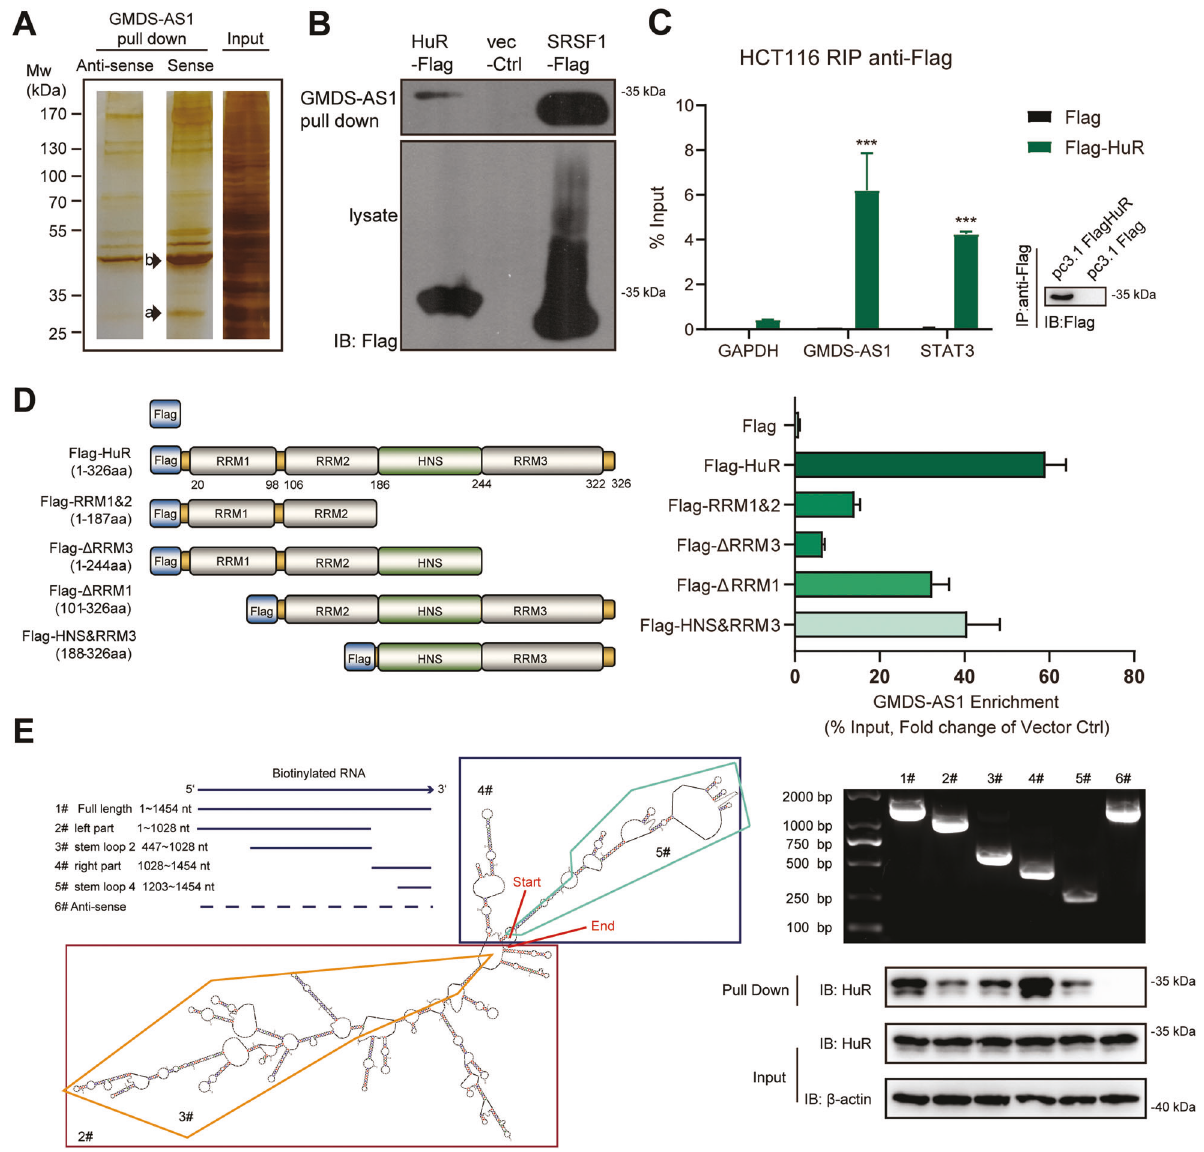
Fig. 5 GMDS-AS1 binds to the HuR protein in CRC cells. A Biotinylated GMDS-AS1-sense and antisense probes were transcribed in vitro and incubated with HCT116 whole-cell lysates for use in RNA pull-down assays. After SDS – PAGE and silver staining, 28 kDa (arrow a) and 37 kDa (arrow b) GMDS-AS1-sense-speci fi c bands, which repeatedly appeared in two independent assays, were excised and analyzed by mass spectrometry. B Streptavidin RNA pull-down assays and western blotting were performed, and the results validated the speci fi c interactions of HuR or SRSF1 protein with GMDS-AS1. Representative results based on three independent experiments. C Plasmids expressing Flag-tag alone and Flag-HuR were transfected into HCT116 cells, and RIP experiments were performed using antibodies against Flag; qPCR was used to detect GMDS-AS1 and STAT3 mRNA levels. GAPDH mRNA was used as the non-HuR target negative control. The values are expressed as the means ± SEM, n = 3. *** p < 0.001 by two-tailed Student ’ s t test. D Deletion mapping was performed to identify the GMDS-AS1 binding domain in HuR in HCT116 cells. HNS HuR nucleocytoplasmic shuttling sequence, RRM RNA recognition motif. Plasmids expressing a Flag-tag, Flag- tagged full-length HuR or Flag-tagged truncated HuR were transfected into HCT116 cells, and RIP experiments were performed using antibodies against Flag. qPCR was performed to detect the GMDS-AS1 enrichment levels. E Western blotting of HuR in streptavidin RNA pull- down samples by full-length biotinylated-GMDS-AS1 (1#), truncated biotinylated-GMDS-AS1 RNA motifs (2 – 5#) or biotinylated GMDS-AS1 antisense. The secondary structure of GMDS-AS1 was analyzed by Sfold axis (width, W ) were measured twice per week, and the tumor volume was calculated with the formula V = 0.5 × L × W 2 . All mice were sacri fi ced from 4 to 5 weeks after the injection, and the tumors were removed and weighed.